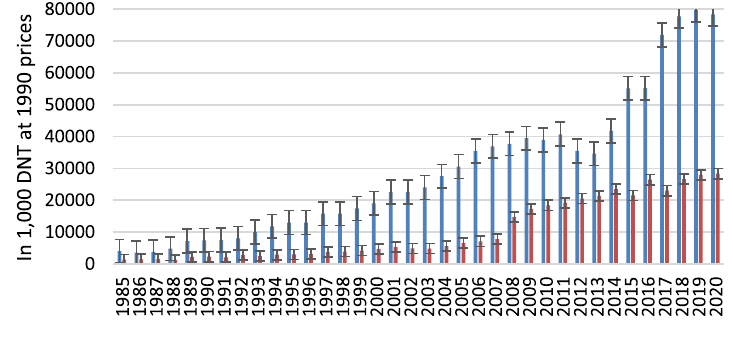
Fig. 1 Evolution of Tunisia’s international trade in goods and services (in 1000 DNT at 1990 prices). Source Compiled by the author from data collected from several issues of the Statistical Yearbook of Tunisia